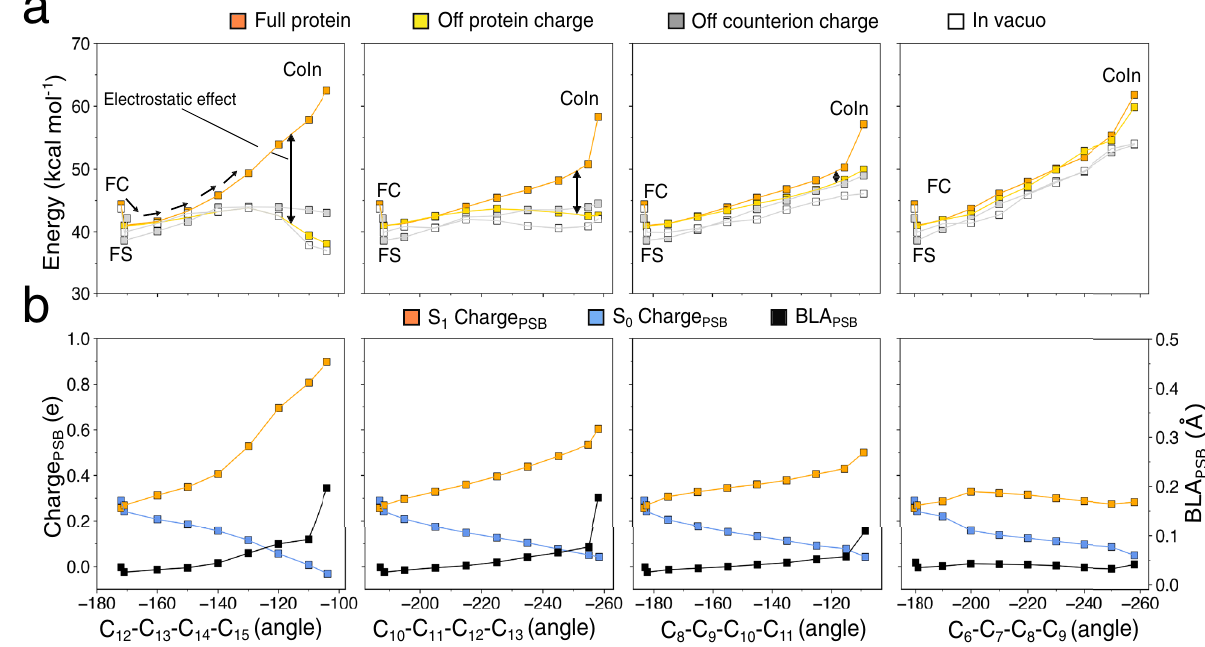
Fig. 4 | S 1 energy, charge and BLA pro fi les along the photoisomerization of, from left to right, C13=C14, C11=C12, C9=C10 and C7=C8 double bonds. a CASPT2S 1 energy pro fi les computed in presence of the fullprotein environment (orange squares), after setting to zero the MM charges of the entire protein (gold squares), after setting to zero only the MM charges of the rPSB counterion (i.e.,